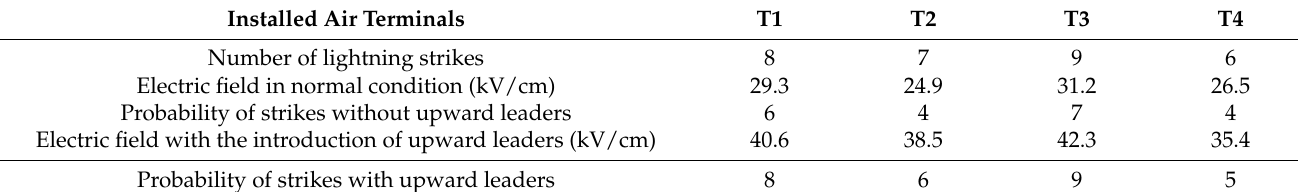
Table 8. Probability of lightning strikes on a cylindrical building.